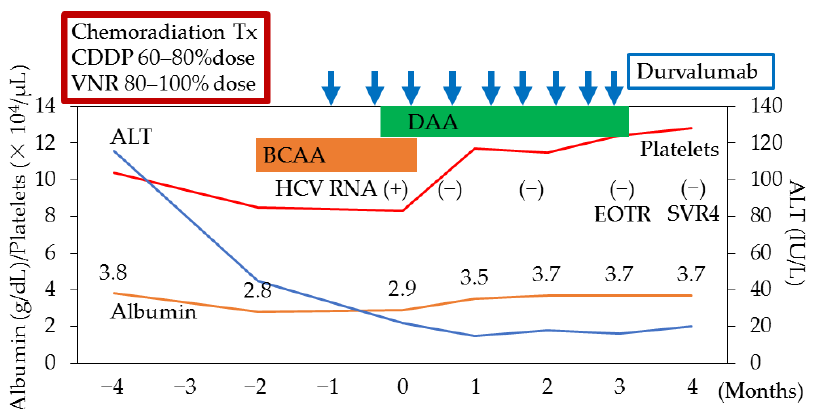
Figure 2. Clinical course of a patient with hepatitis C virus (HCV) infection and decompensated cirrhosis in whom DAA could support sufficient lung cancer chemotherapy. CDDP, cisplatin; VNR, vinorelbine; ALT, alanine aminotransferase; BCAA, branched-chain amino acid; DAA, direct-acting antiviral against HCV; EOTR, end of the treatment response; SVR4, sustained virological response at week 4.